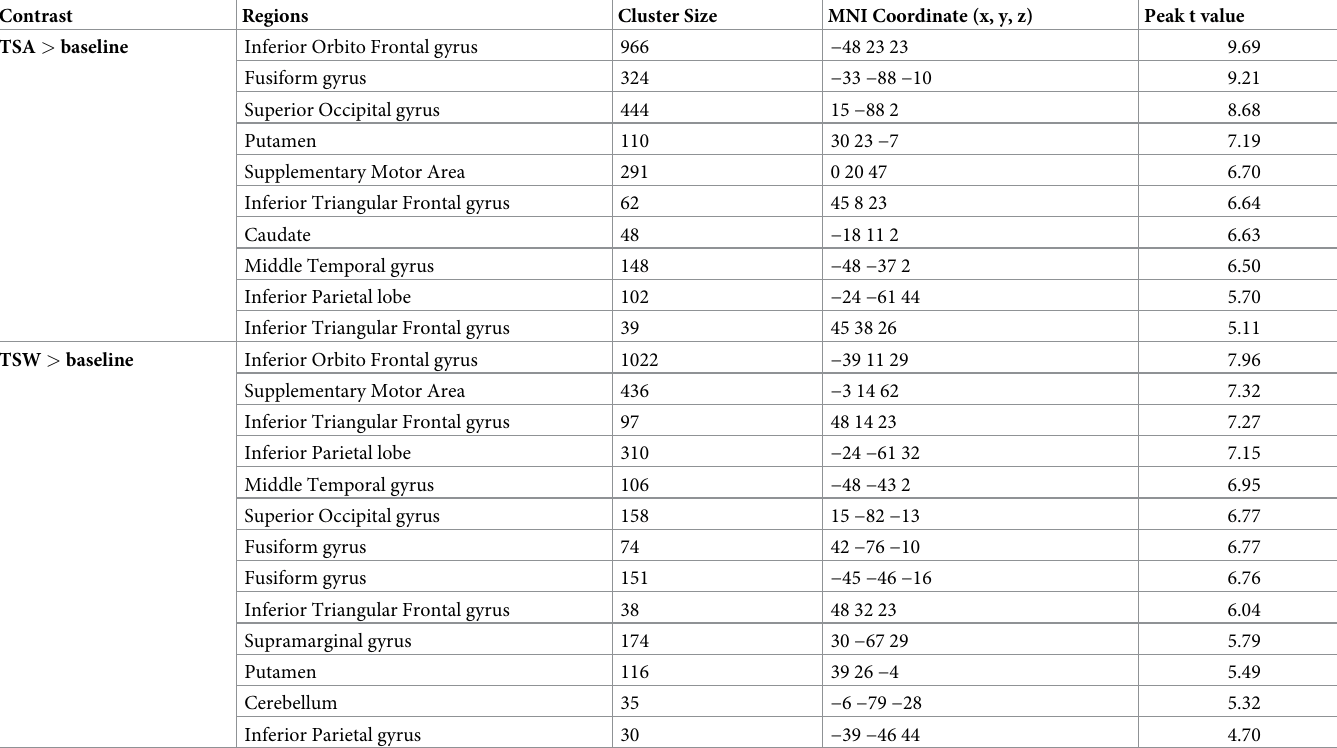
The regions reported for contrasts with baseline condition were p < .05 FDR-corrected at a cluster level, p < .001, K s > 30 at a voxel level.